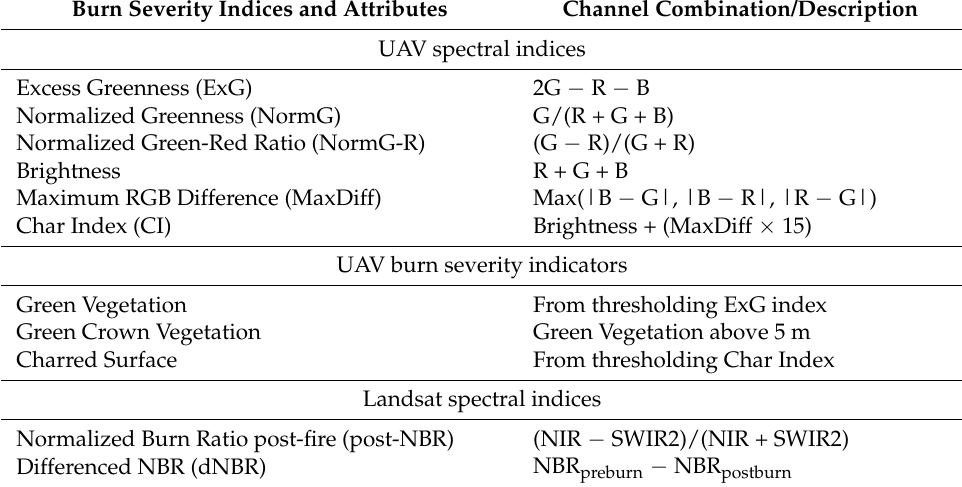
Table 2. Description and formulation of UAV burn severity spectral indices, UAV burn severity indicators derived from the UAV indices, and Landsat spectral burn severity indices investigated in this study. NIR refers to Landsat’s near infrared channel and SWIR2 refers to the second shortwave infrared channel centered at 2.2 µ